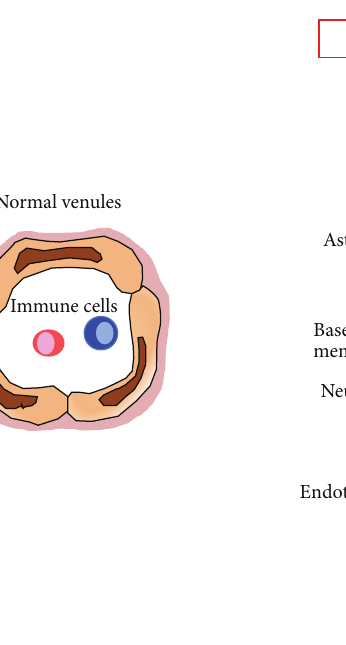
Figure 1: Venules at the blood-brain barrier in the CNS and other organs. Venules at the blood-brain barrier consist of specific endothelial cells that are brought together by tight junctions and tight liner sheets formed by pericytes and astrocytic end-feet. These are not present in normal venules